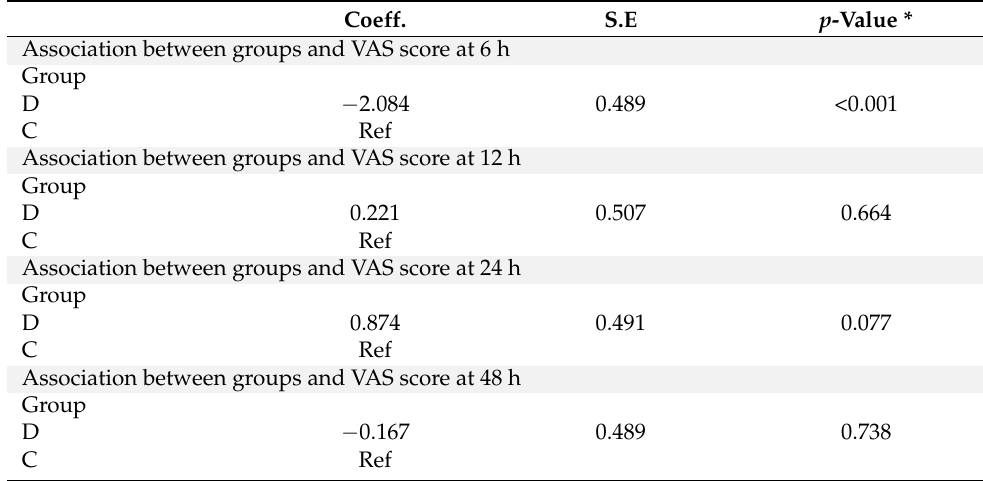
Table 4. Association between groups and VAS at each time point. Coeff. S.E p -Value * Association between groups and VAS score at 6